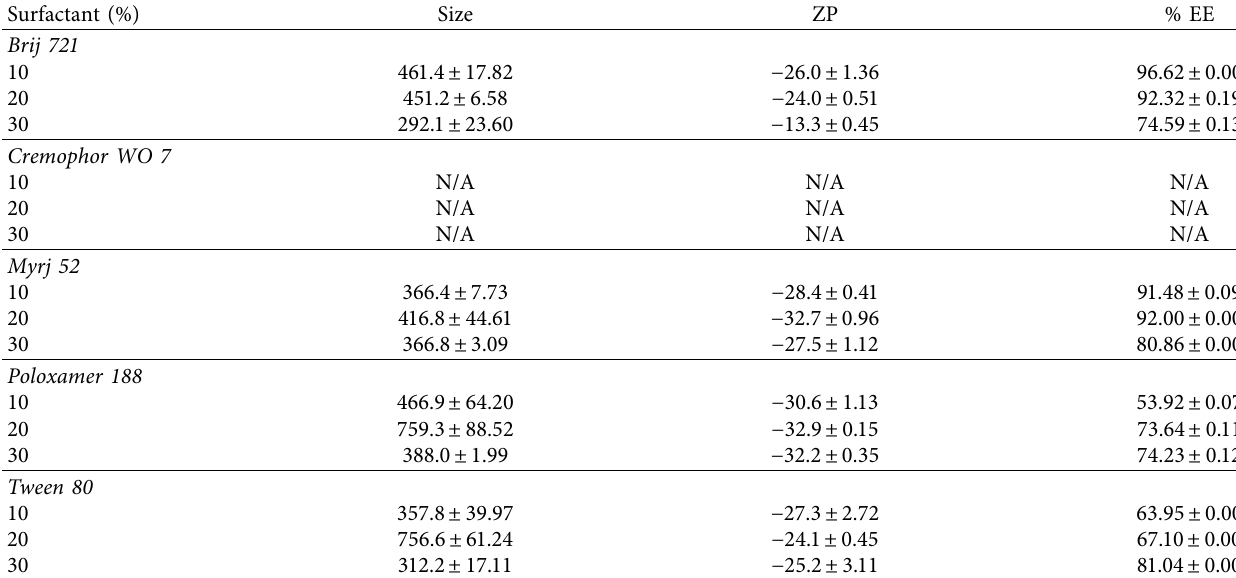
Table 4: The comparison of the particle size of zeta potential and % entrapment efficiency of the formation containing vitamin E ( n � 3); ZP: zeta